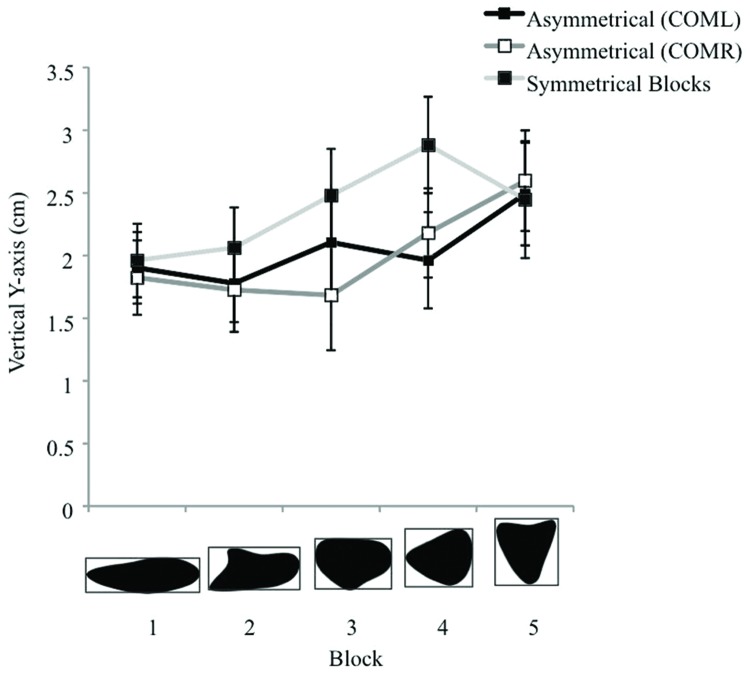
Displays the vertical fixation locations (cm) when grasping the Asymmetrical (COML, COMR) and symmetrical objects in Experiment 1. Positive values represent fixation locations above the object’s vertical center. Error bars represent the standard error of the mean.